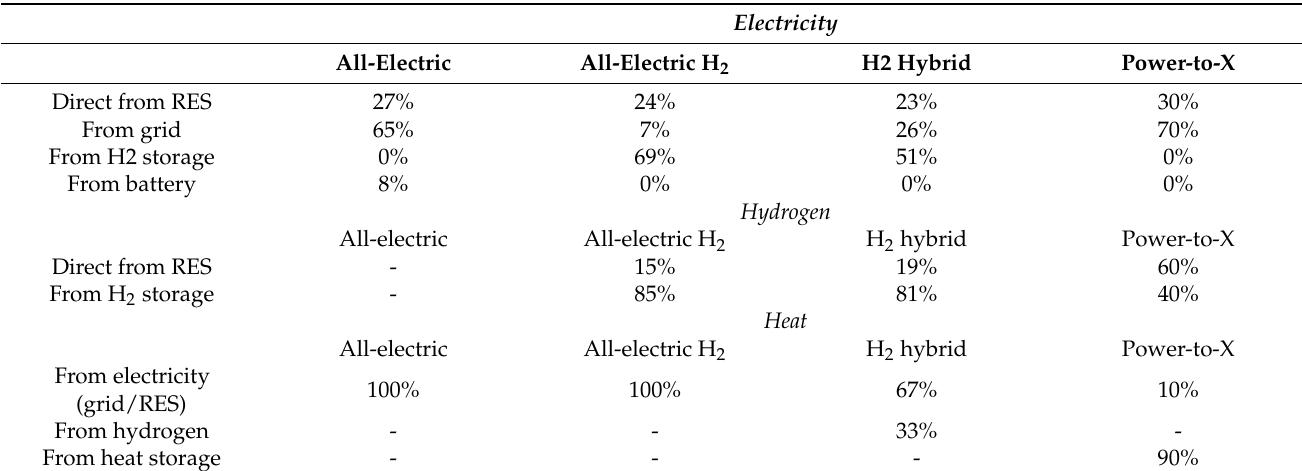
Table 5. Percentages of the electricity, hydrogen and heat demand arranged per energy carrier (electricity, heat, hydrogen) and